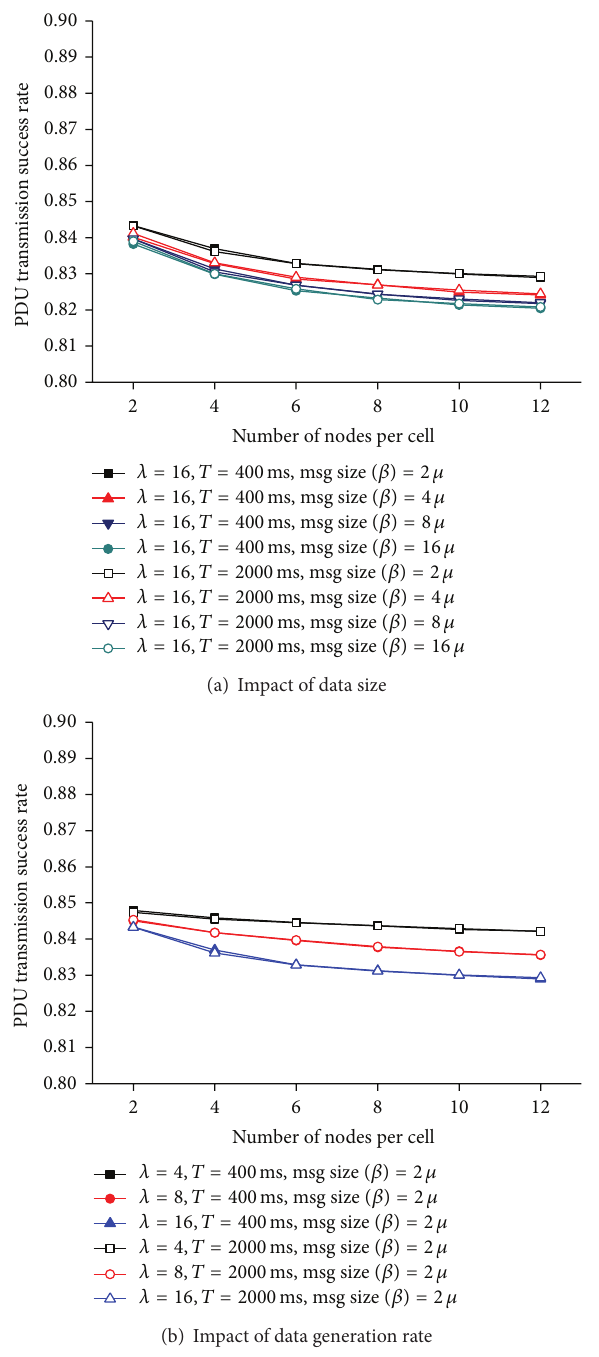
Figure 10: Data transmission success rate in a mobile ad hoc environment.